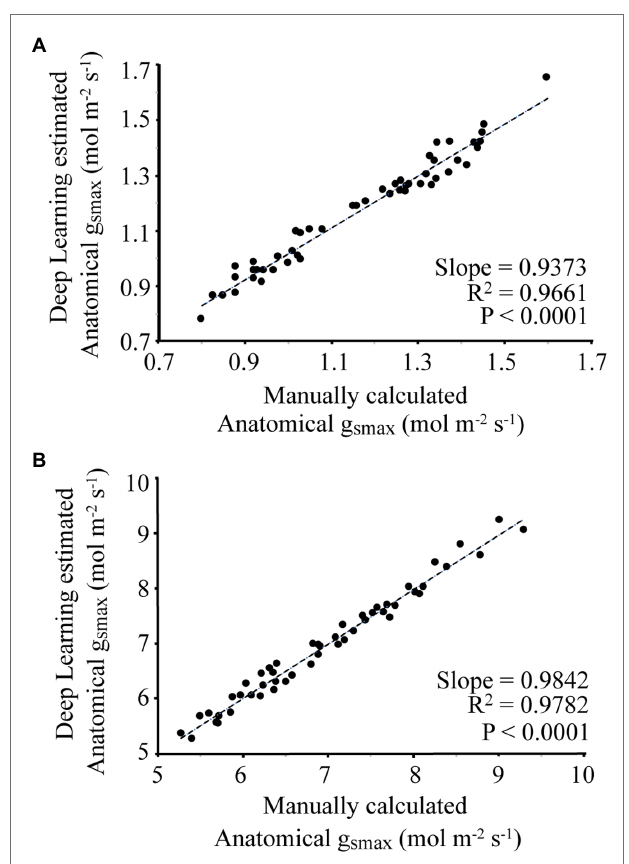
FIGURE 5 | Comparison of manual calculation of g smax by an expert vs. automatic calculation using the proposed deep learning approach where (A) corresponds to the wheat dataset, (B) is the poplar